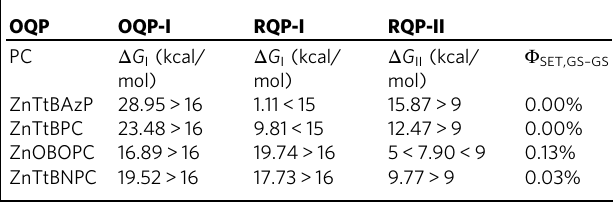
Table 1 Thermodynamic viabilities of PCs with respect to the critical steps in OQP and RQP.